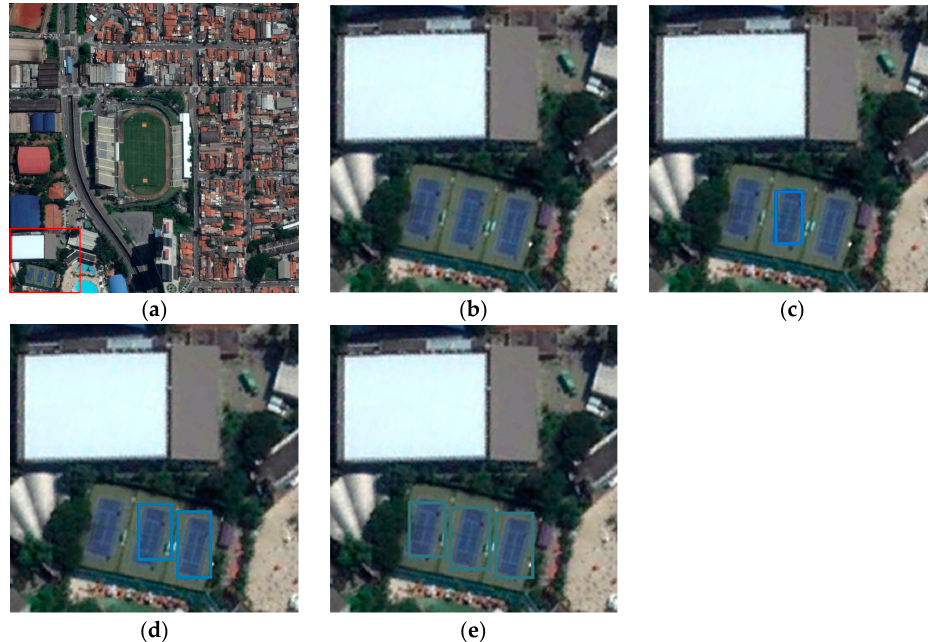
Figure 13. Details of detection results for small object of each methods. ( a ) is the original picture with the red box highlighted. Figure ( b ) shows local details of the original image in the red box. ( c – e ) are the predict results of YoloV4, RetinaNet, and proposed method, respectively. Tennis is one of the small object classes in the DIOR dataset. All boxes in ( c – e ) represent the visualization results of ‘Tennis’.